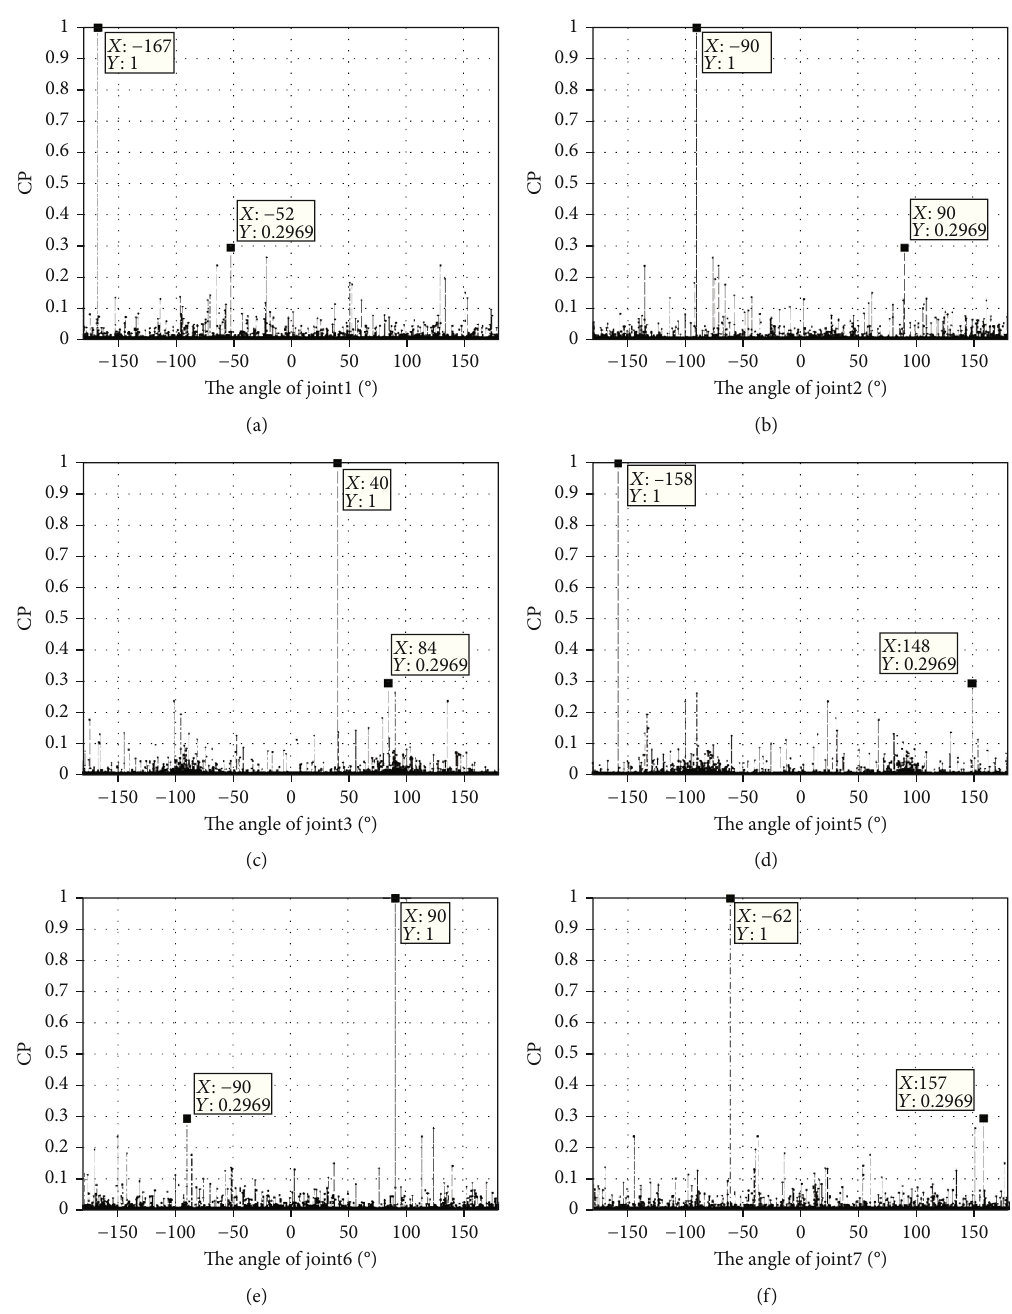
Figure 7: The simulation results of CP which are in the form of a 2-dimensional planar graph. (a) The angle of joint 1 — CP. (b) The angle of joint 2 — CP. (c) The angle of joint 3 — CP. (d) The angle of joint 5 — CP. (e) The angle of joint 6 — CP. (f) The angle of joint 7 —